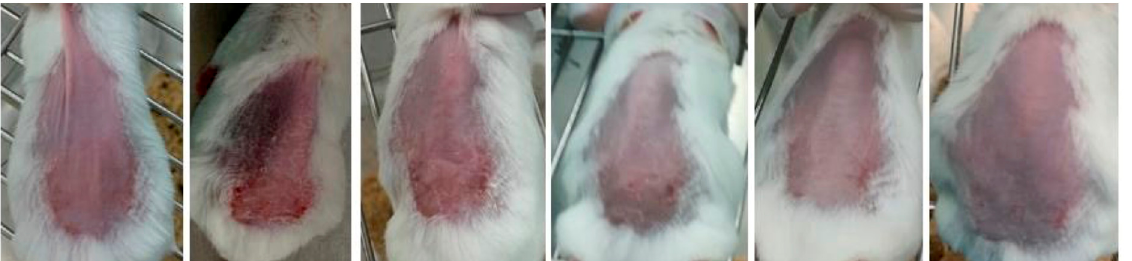
Figure 10. Skin thickness after chemically induced burn and treatment: negative control (Pluronic ® F127 hydrogel, circles); positive control (commercial cream of silver sulfadiazine, squares); and AgNPs incorporated in Pluronic ® F127 hydrogel (triangles).